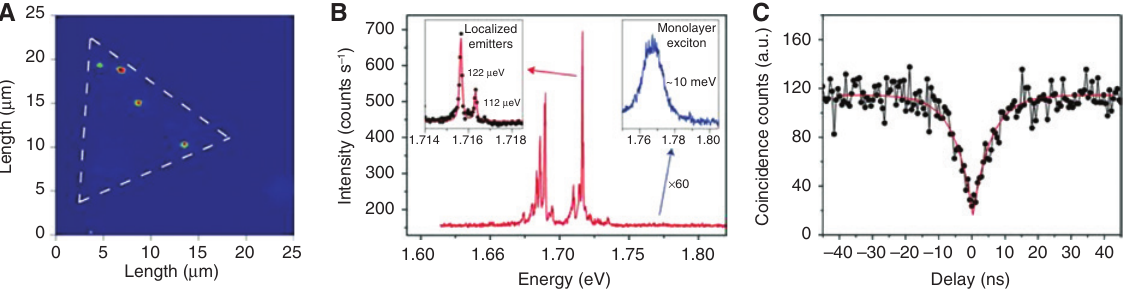
Figure 1: Fluorescence from quantum emitters in 2D semiconductors. (A) Scanning confocal PL image of the spectrally narrow emitters. (B) PL spectrum of localized emitters. Left inset, high-resolution spectrum of the highest-intensity peak; right inset, zoom-in of the monolayer valley exciton emission integrated for 60 s. The emission of the localized emitters exhibits a red shift and much sharper spectral lines. (C) Second-order correlation measurement of the PL from a typical localized emitter. Reproduced with permission from Ref. [6], Nature Publishing Group.